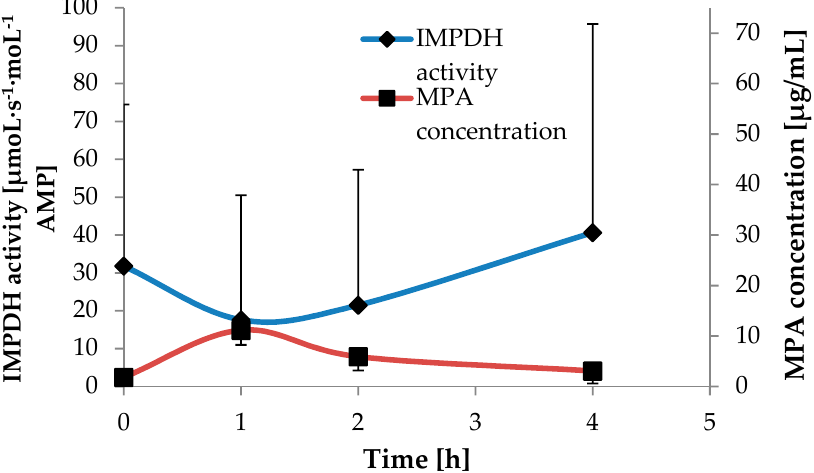
Figure 3. The individual values of inosine 5’-monophosphate dehydrogenase (IMPDH) activity in relation to time elapsed after mycophenolate mofetil (MMF) administration in 12 children with nephrotic syndrome.